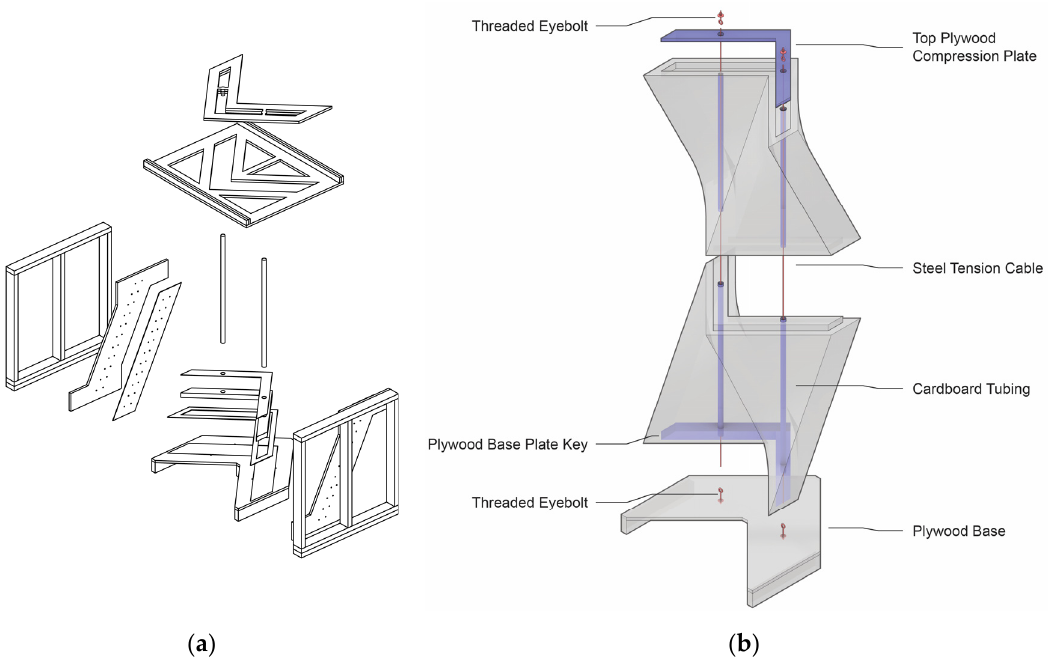
Figure 8. Design diagrams for L’Orso Funigno. ( a ) Exploded axonometric diagram of the formwork apparatus created to grow the monolithic wall units; ( b ) axonometric diagram of the monolithic wall units highlighting the post-tension system that applied a compressive force on the units with a mechanically tightened cable between plywood base and top plate. Drawings by Emmett Lockridge.